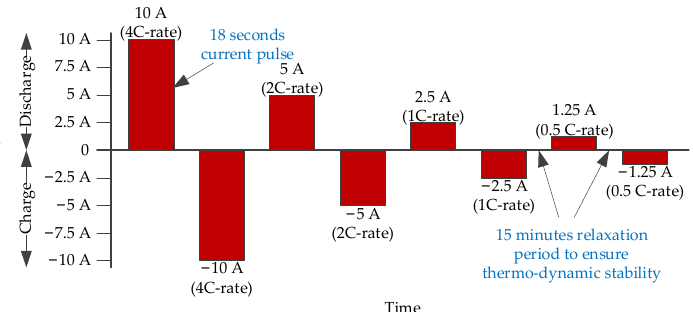
Figure 3. Current pulse train profile applied to measure the internal resistance of the LiFePO 4 /C battery cells at 20%, 50% and 80% state of charge (SOC).